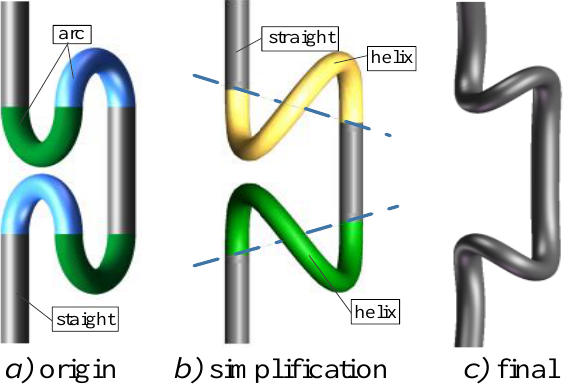
Figure 4. S-crawler gait generation process.